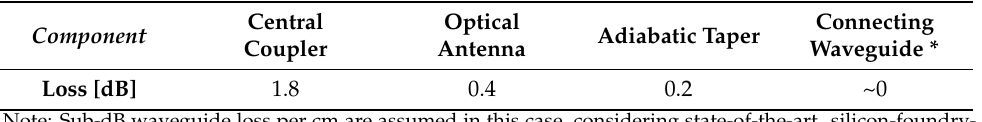
Table 2. Passive photonic elements in the circular optical phased